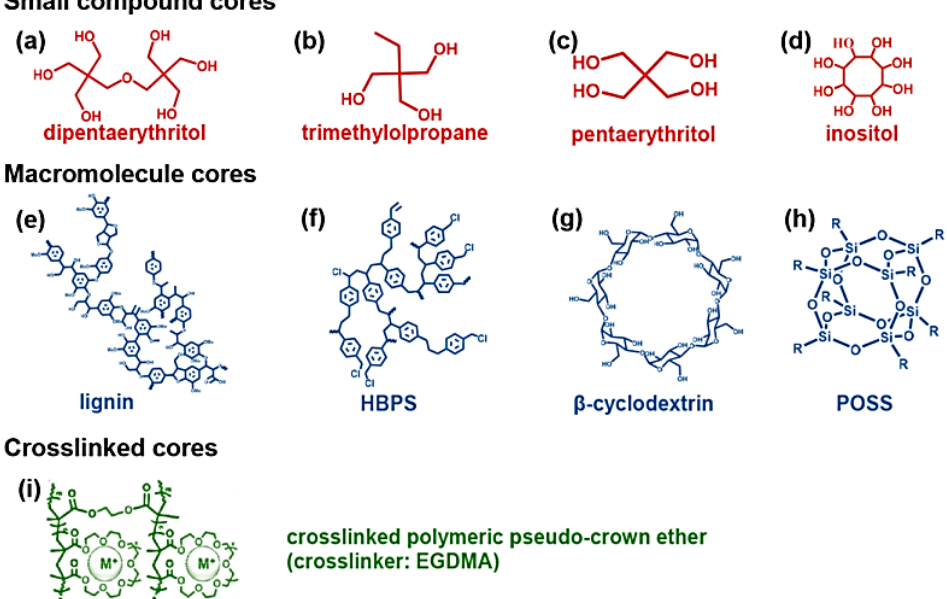
Figure 5. Chemical structures of ( a − d ) small compounds, ( e − h ) macromolecules, and ( i ) cross-linked cores for SP-PEs. ( i ) Reproduced with permission from Ref. [61]. Copyright 2021 cores for SP-PEs. ( i ) Reproduced with permission from [61]. Copyright 2021 ACS.